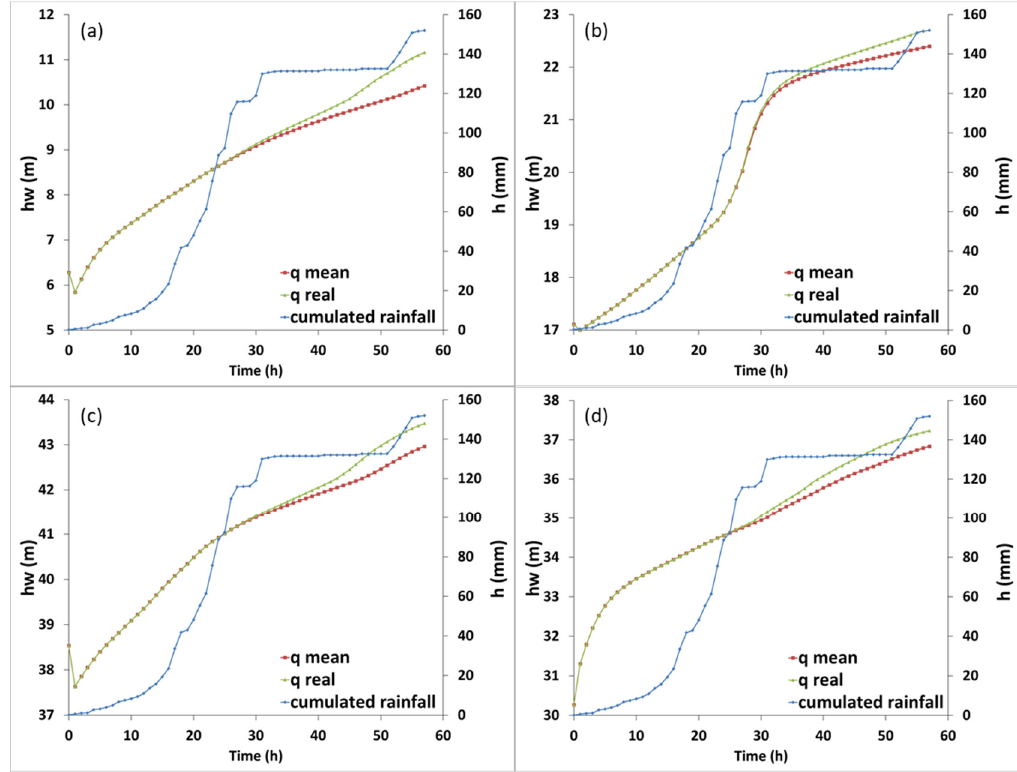
Figure 6. Variation with time of the cumulated rainfall and pore water pressure resulting from the seepage analysis for Nodes 1 ( a ), 2 ( b ), 3 ( c ), and 4 ( d ). Node locations are shown in Figure 5.